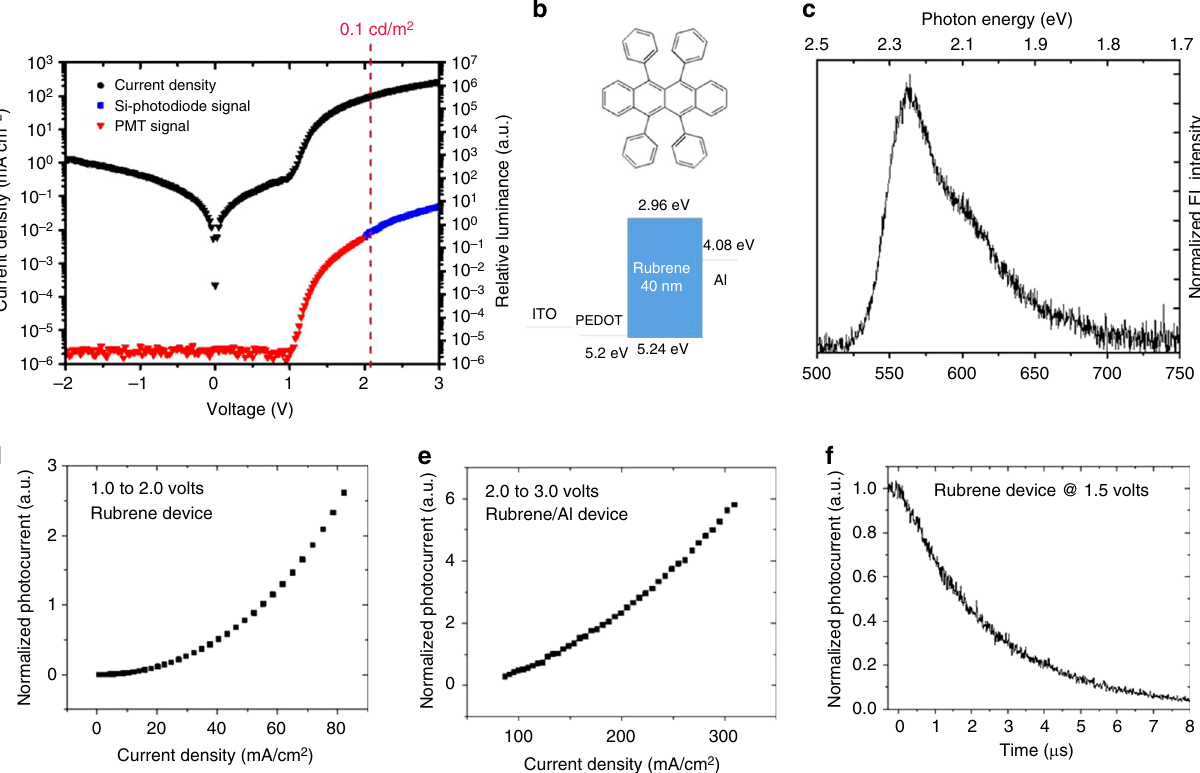
Fig. 3 Single layer rubrene device. a Current density and relative luminance versus voltage. b Molecular structure of rubrene and the energy level diagram of the corresponding single layer device. c EL spectrum. d Photocurrent vs. current density in the low-voltage region and e in the high-voltage region. f Transient EL dynamics of the device after